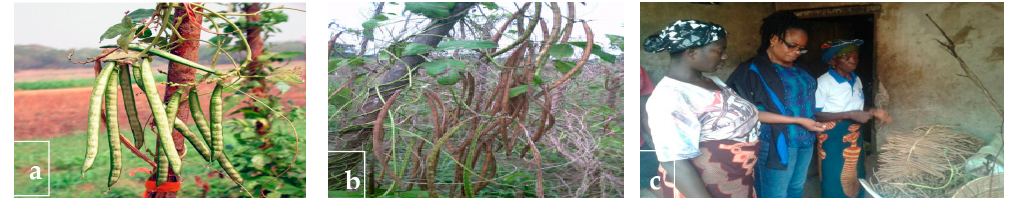
Figure 9. Sphenostylis stenocarpa. ( a ) Mature but not ready to harvest the fruits of the African yam bean; ( b ) dried fruits; ( c ) dried harvested fruits stored beside the house by one of the respondents. Photo © Adewale and Nnamani.